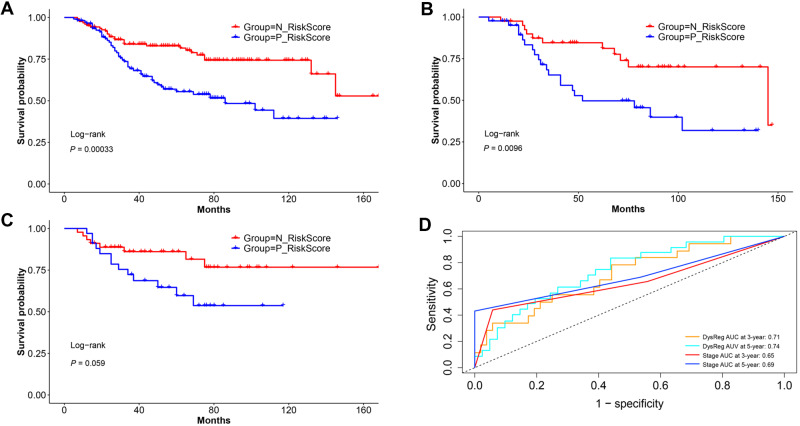
Predictive power of 4-DysReg for chemotherapeutic benefit in GSE39582. (A‒C) Kaplan‒Meier curves for OS predicted by 4-DysReg between positive and negative risk score groups in all ADJC (A), combined ADJC (B), and 5-FU (C). (D) Time-dependent ROC for combined ADJC. N_RiskScore, negative risk score predicted by 4-DysReg; P_RiskScore, positive risk score predicted by 4-DysReg. P-value was generated from log-rank test.